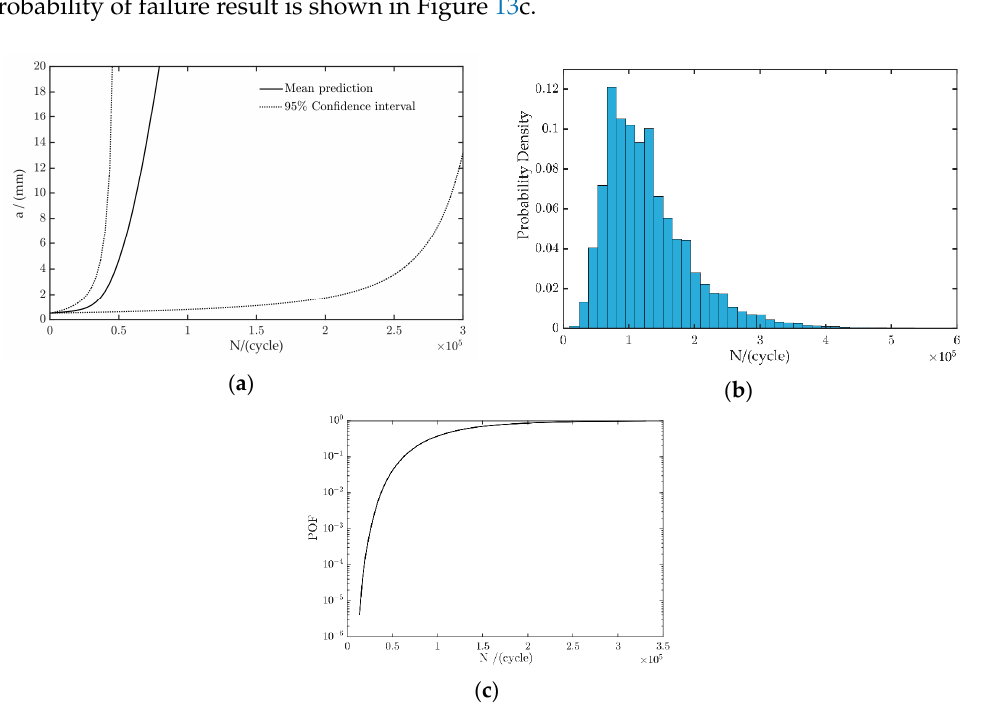
Figure 13. Fatigue life and reliability evaluation results of embedded elliptical cracks: ( a ) fatigue crack propagation curve, ( b ) fatigue life distribution, and ( c ) failure